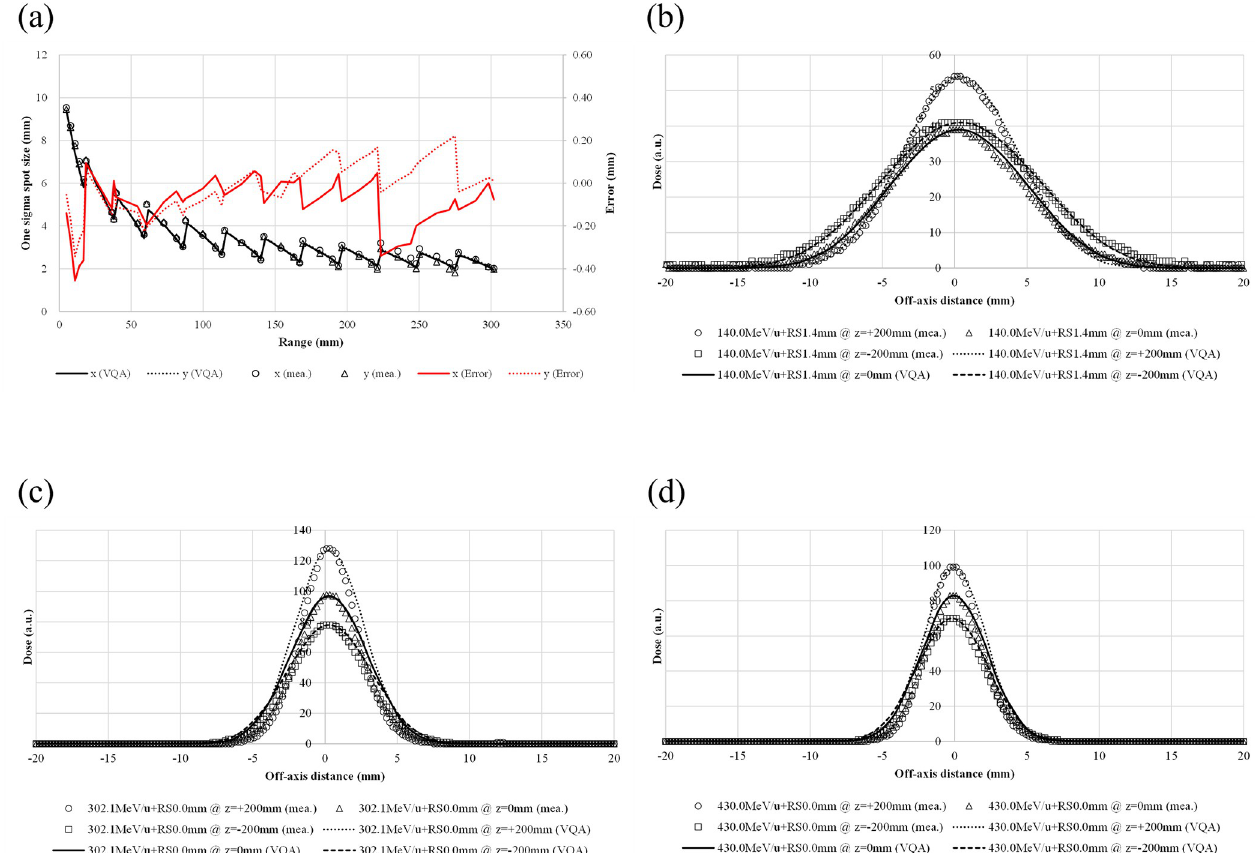
Fig 2. In-air spot sizes and profiles for selected energies. (a) The beam size defined by one sigma in the isocenter plane ( z = 0) vs. energy—solid line: calculated spot size in the x -direction; dotted line: calculated spot size in the y -direction; circles: measured spot size in the x -direction; triangles: calculated spot size in the y -direction; red solid line: error in the spot size in the x -direction; red dotted line: error in the spot size in the y- direction. The lateral in-air dose profiles are shown for a pencil beam at selected energies and different positions. The selected energies are (b) 140.0 MeV/u, (c) 302.1 MeV/u, and (d) 430.0 MeV/u. The lateral in-air dose profiles are measured at z = +200 mm (circles), 0 mm (triangles), and − 200 mm (squares), whereas they are calculated at z = +200 mm (dotted lines), 0 mm (solid lines), and − 200 mm (dashed lines).